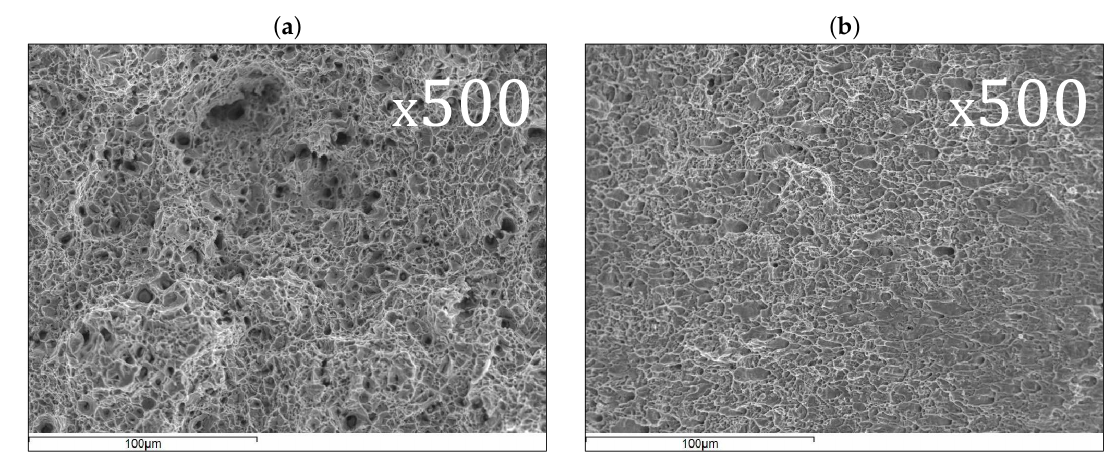
Figure 6. Fractographs obtained from the 9 mm-diameter specimen made of Material 2 [26]. ( a ) Detail of the central region (cup). ( b ) Detail of the external region